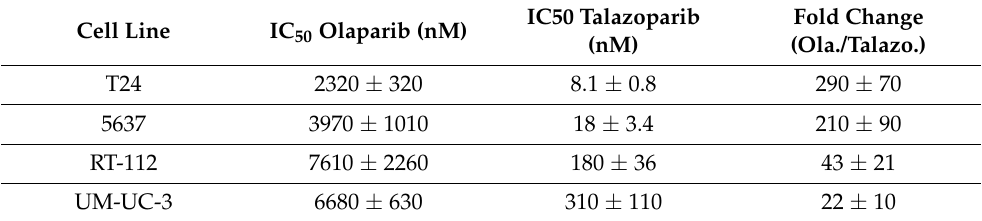
Figure 2. Superior efficiency of Talazoparib compared to Olaparib against bladder cancer cells. Cells were treated for 5 days with Olaparib (Ola.) or Talazoparib (Talazo.), and cell viability was measured using a Sulforhodamin B assay. The datapoint at 0 µM indicates treatment with DMSO as control. Table 1. Overview of IC 50 concentrations and fold changes when comparing the Poly-(ADP-Ribose) Polymerase inhibitors Olaparib and Talazoparib in bladder cancer cell lines.